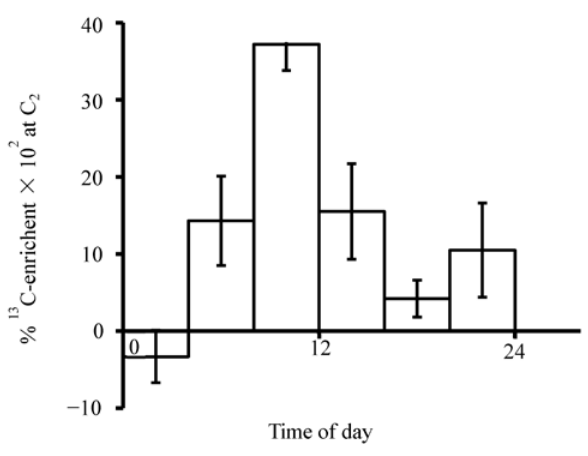
Figure 3. Diurnal changes in mean percentage 13 C-enrichment at C 2 after ingesting 2- 13 C-histidine. These are based on the data at six 4-h periods (Figure 2). Each column from left to right includes data from 6, 6, 12, 11, 6, and 6 urine voids. Vertical line represents